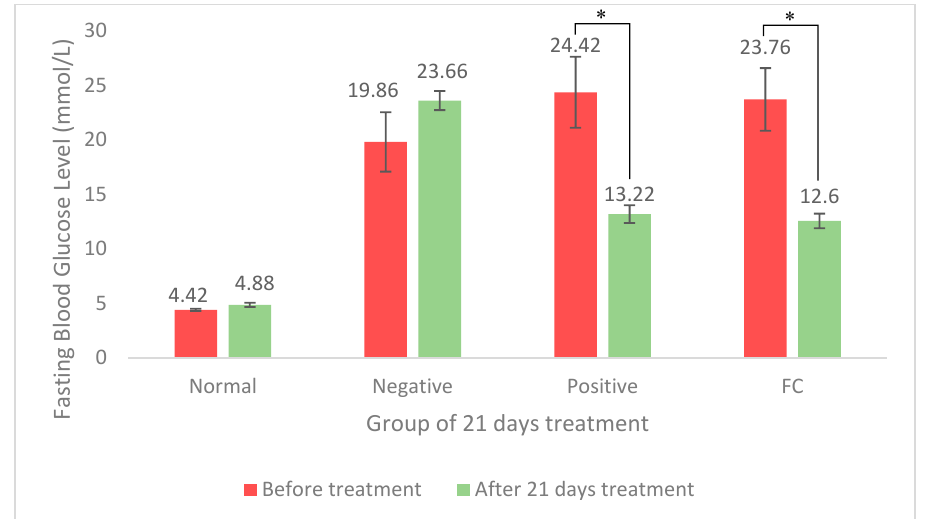
Figure 1. Fasting blood glucose level of rats from normal (normal group with distilled water), negative (diabetic group with distilled water), positive (diabetic group with 300 mg / kg metformin), and Ficus carica (FC) (diabetic group with 400 mg / kg Ficus carica aqueous extract). Symbol “ * ” represents significant difference ( p < 0.05).